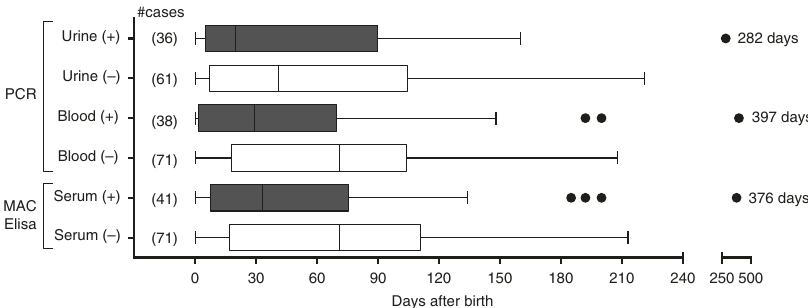
Fig. 1 Timing of positive and negative ZIKV laboratory results over time by age. The fi gure re fl ects the number of assays performed in each assay category in specimens collected from 130 children. There were 161 serum specimens run for ZIKV PCR and ZIKV IgM and 85 urine specimens run for ZIKV PCR. The vertical line in the box represents the median, the box the interquartile range (10 – 90% of the data), and the whiskers the 95% con fi dence interval. The fi gure represents all the assays performed, not the number of children. All IgM assays were run once and in duplicate and all PCR assays were run once in triplicate. Children can be represented more than once. Error bars represent the standard deviation. Table 2 ZIKV vertical transmission by age and assay